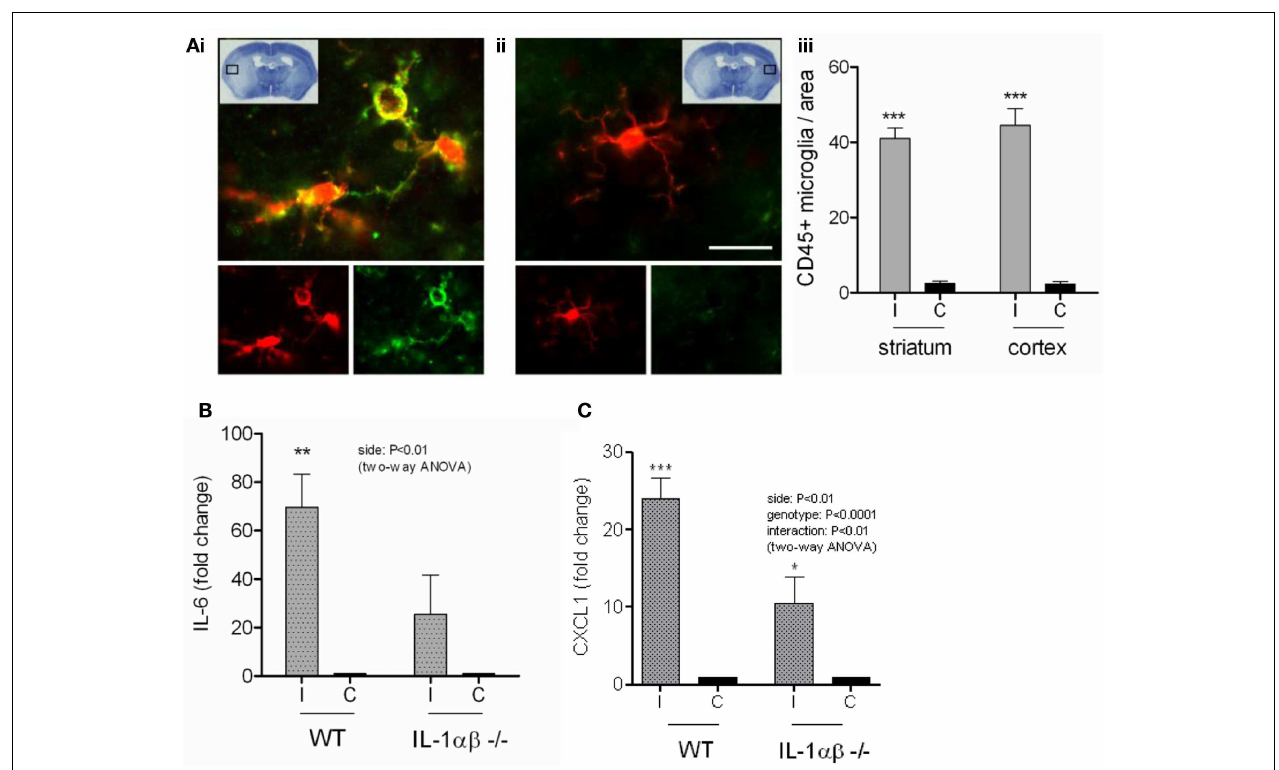
CXCL1 (C) increase significantly in the ipsilateral cortex ofWT mice after tMCAo. IL-6 and CXCL1 protein levels are significantly attenuated in IL-1 α / β KO mice (B,C) . Data are expressed as fold increase over the contralateral hemisphere, are from a minimum of three independent experiments and were analyzed by two-way ANOVA followed by a Bonferonni post hoc analysis. ** P < 0.01, * P <